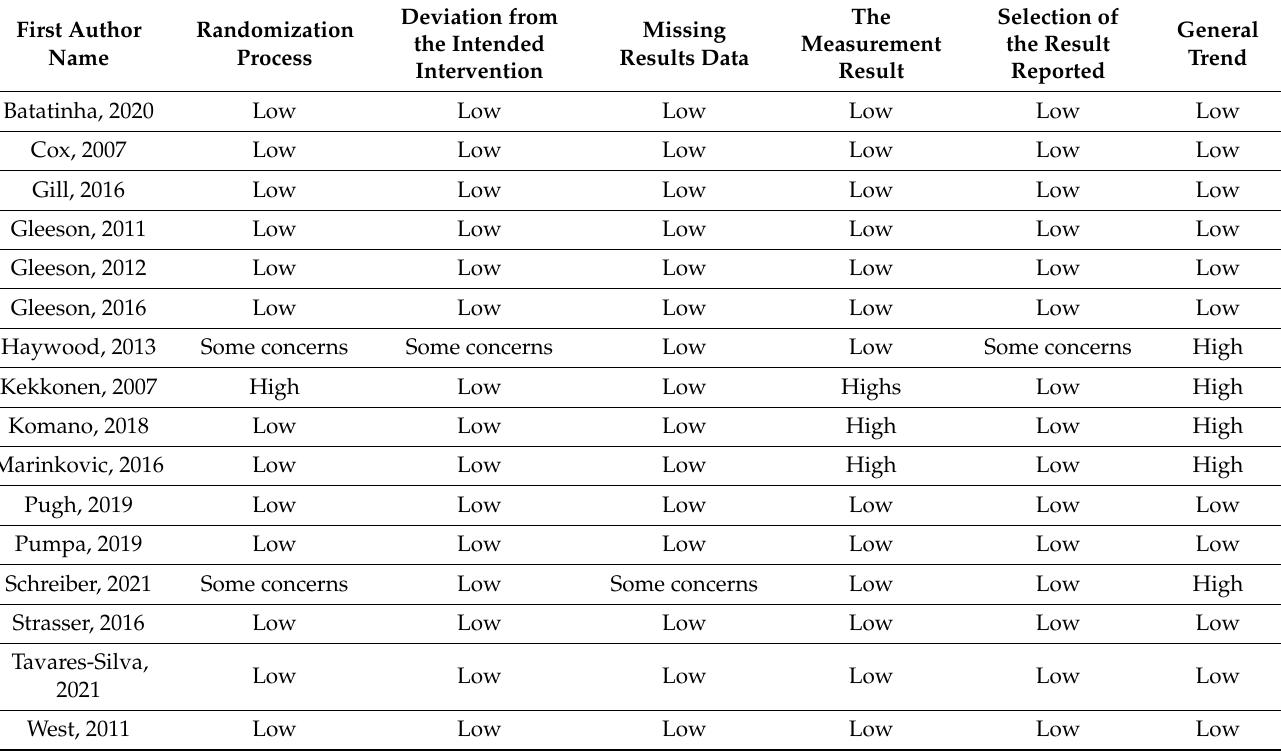
Table 3. Methodological quality of the studies using the tool RoB